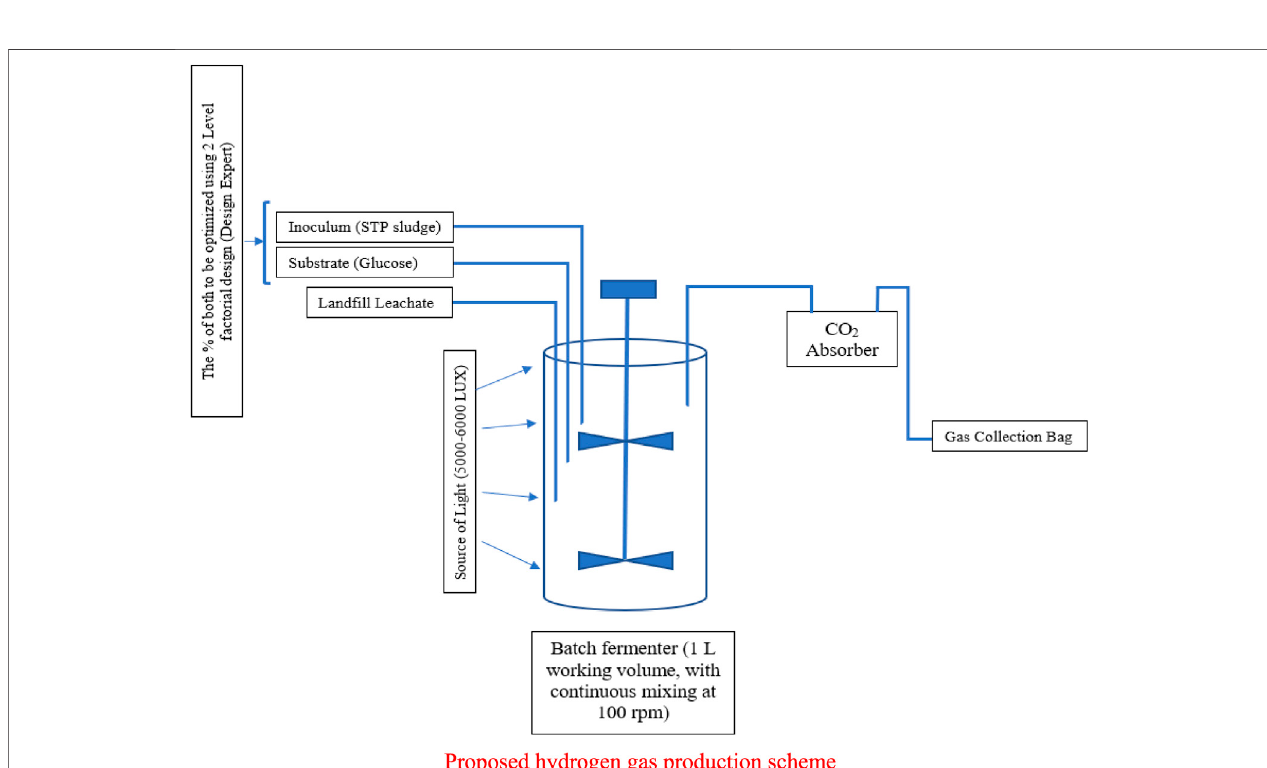
FIGURE 13 | Proposed hydrogen gas production